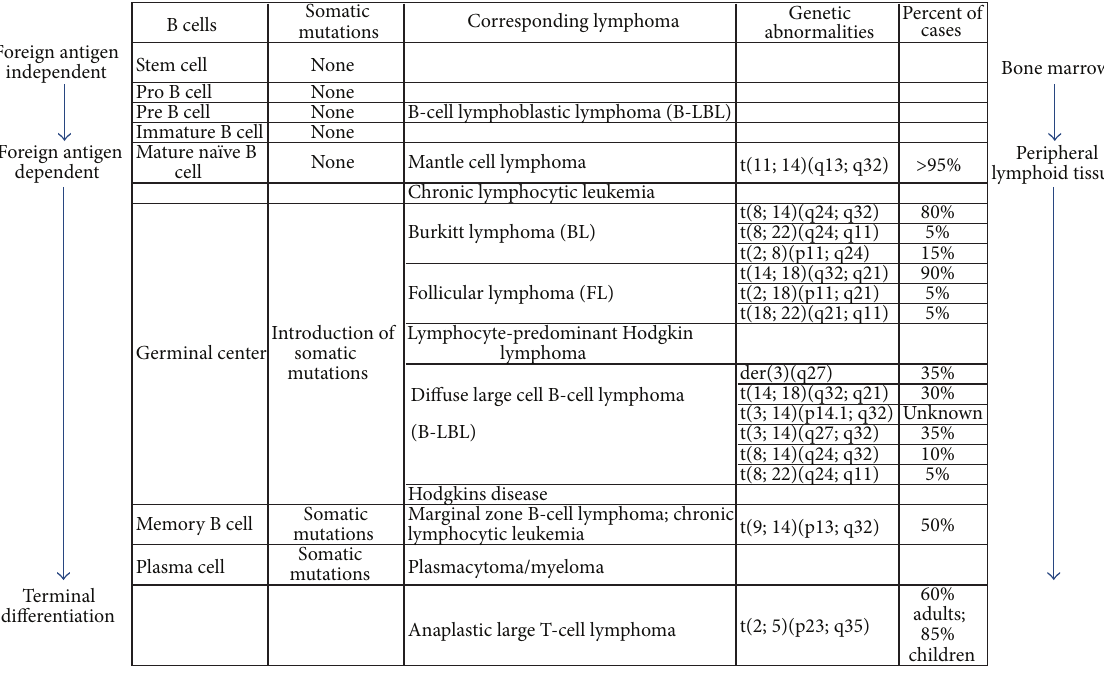
Figure 6: Key steps in the development of